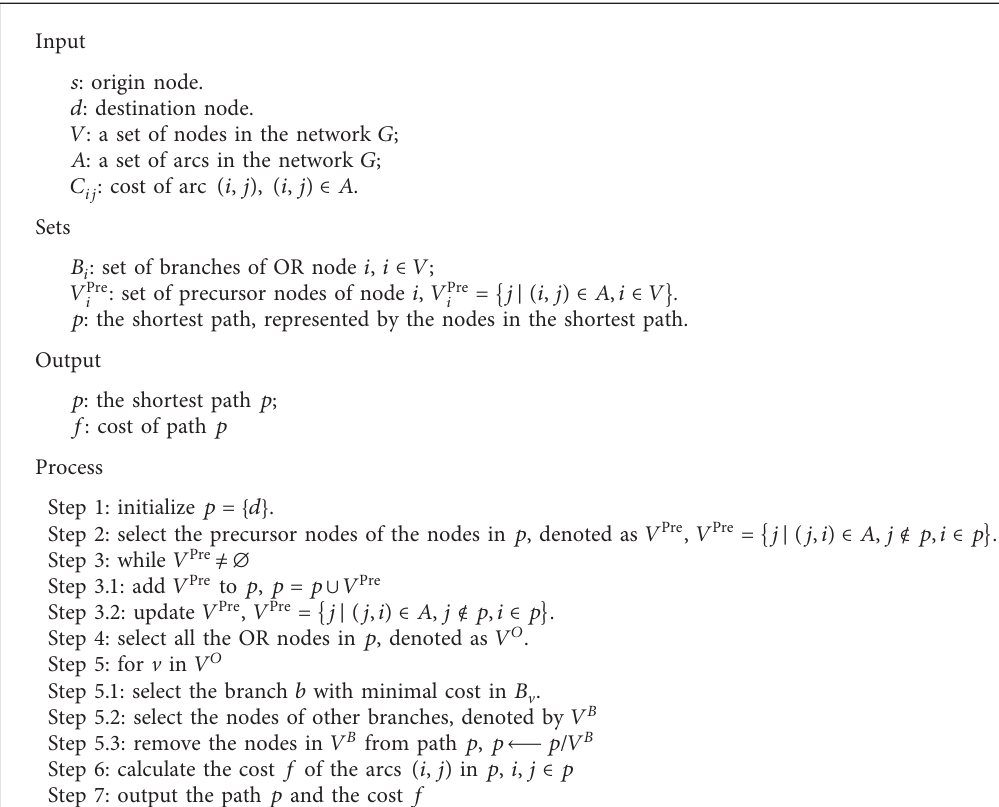
Figure 3: Algorithm 2 generates paths which selects the branches of an “OR” node. (a) A constructing path v constructing path v